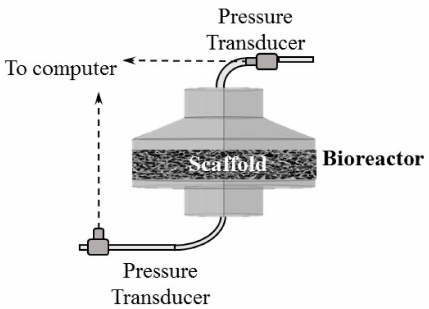
Figure 3. Flow-scheme to determine the pressure drop across the porous